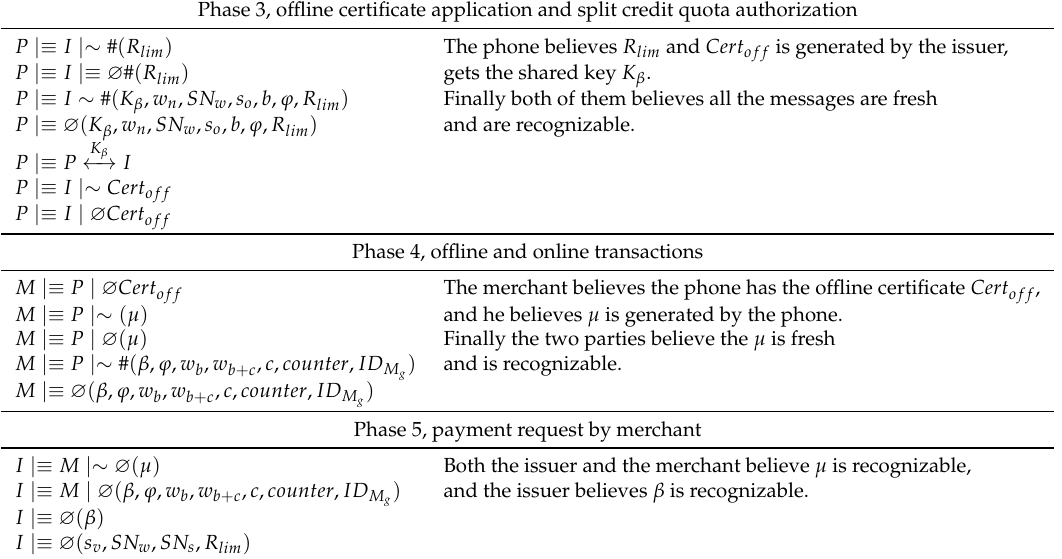
Table 5. Goals of proposed